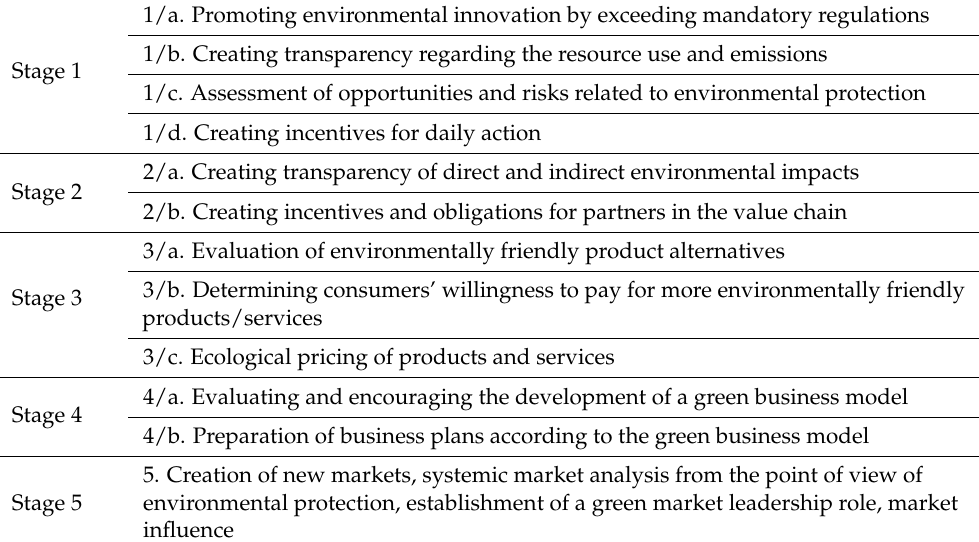
Table 5. Variables included in the questionnaire. Source: edited by